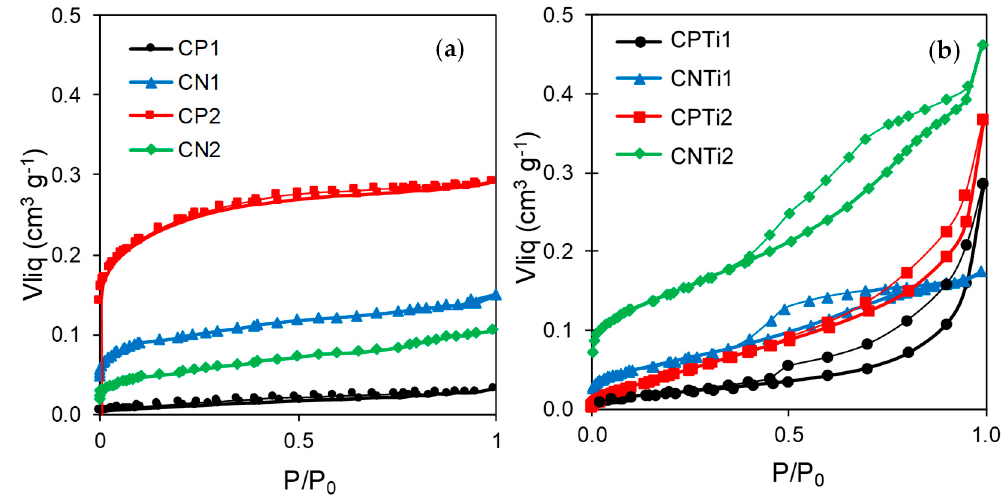
Figure Figure 6. N 2 adsorption–desorption isotherms of ( a ) the pure carbon materials and ( b ) the carbon–Ti composites.